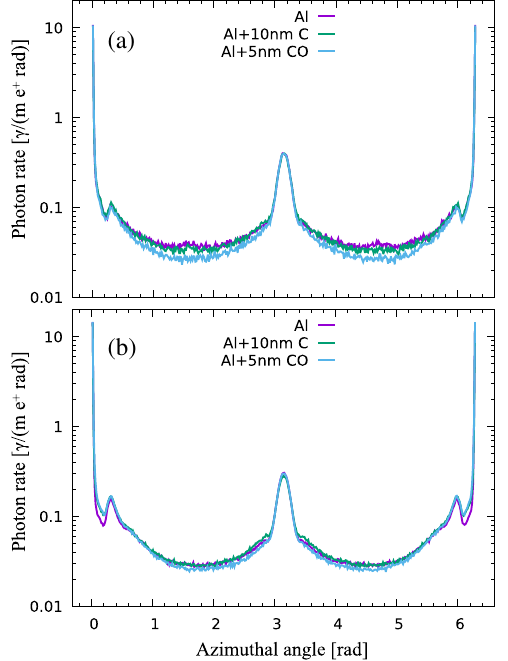
FIG. 14. Azimuthal distribution of photon absorption rate averaged over (a) field-free and (b) dipole regions of the CESR ring. (Beam energy is 5.3 GeV.)